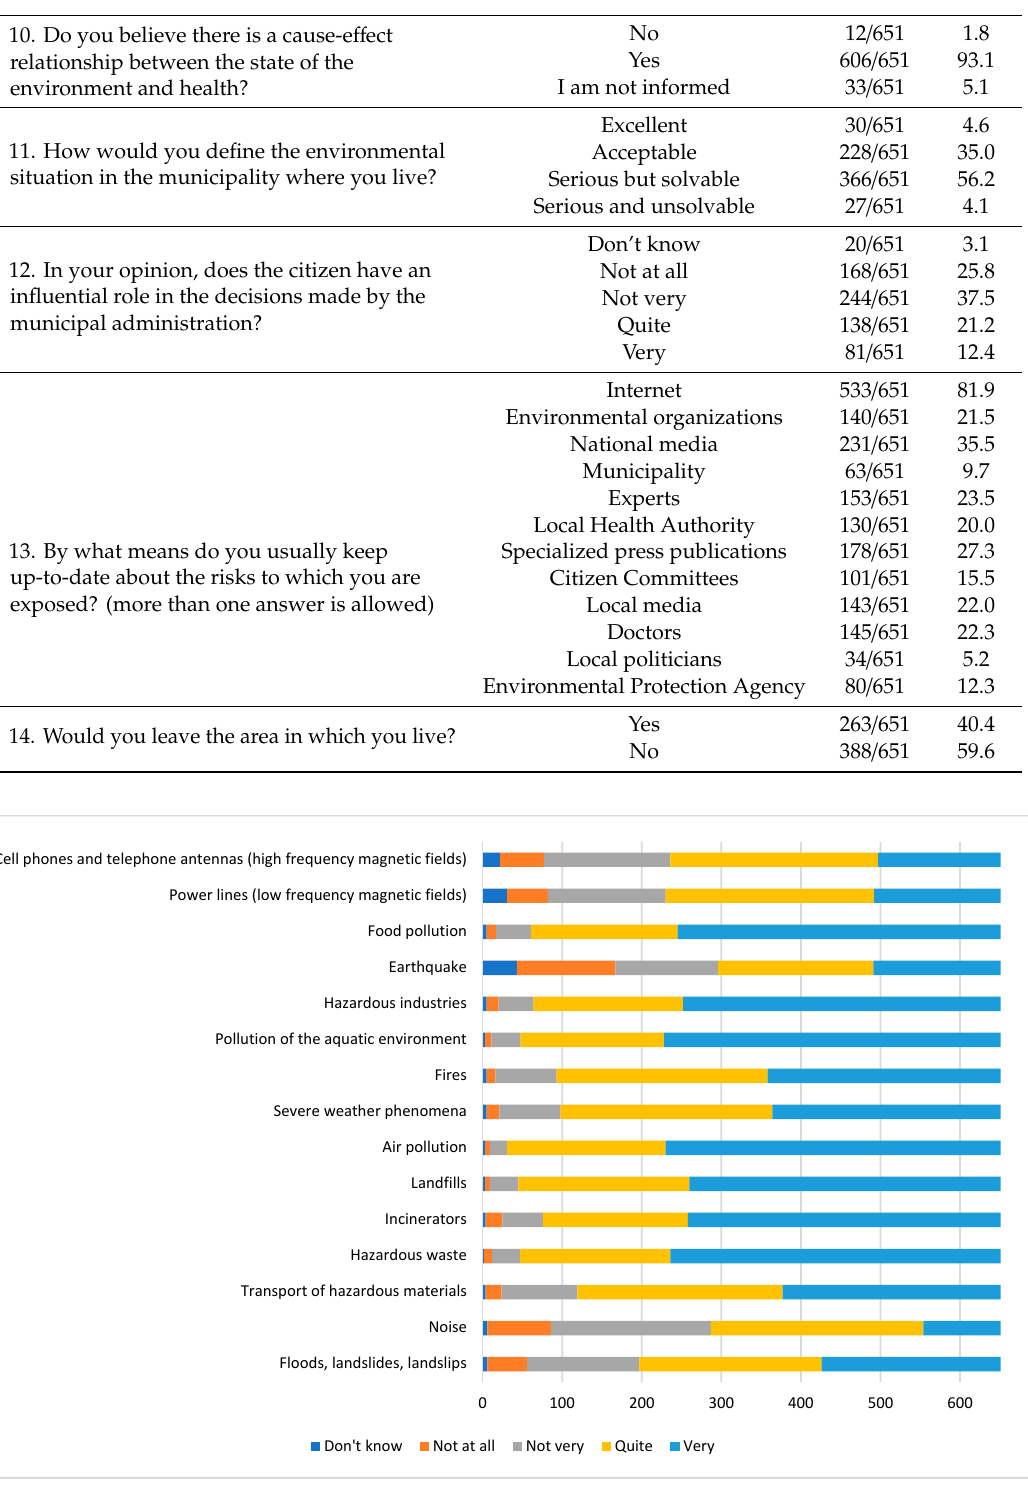
Figure 3. Perception of health problems declared by respondents.